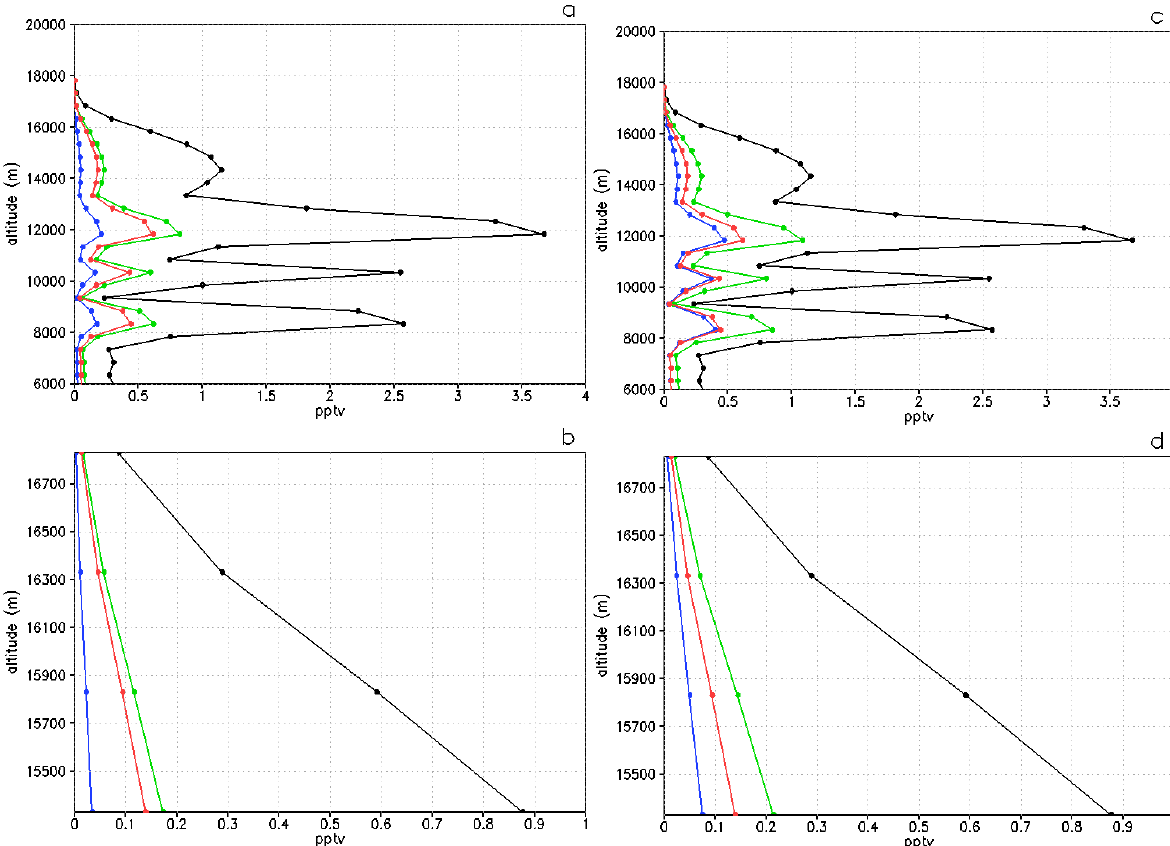
Figure 13: Mean profiles at the end of the convective event (t 0 +110 min) of BrWMR for inorganic PGs(blue), organic PGs (red), total PGs (green) and CHBr 3 (black) averaged horizontally in the PERT1 simulation for a) cloud pH = 5, in the altitude range 6-20 km, b) cloud pH = 5 in the TTL c) cloud pH = 4, in the altitude range 6-20 km, d) cloud pH = 4, in the TTL. [Cl − ] = 5 × 10 − 4 mol l − 1 . The cloud pH is assumed to be 5.